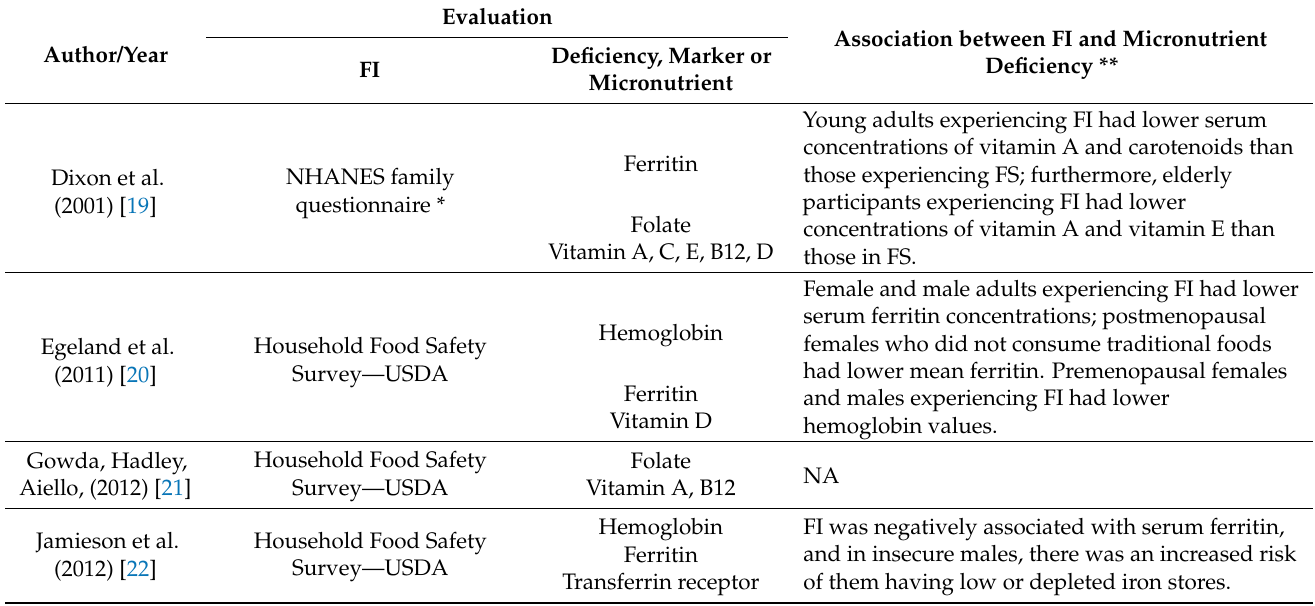
Table 2. The instruments used to assess food insecurity, micronutrient deficiencies, and the prevalence across